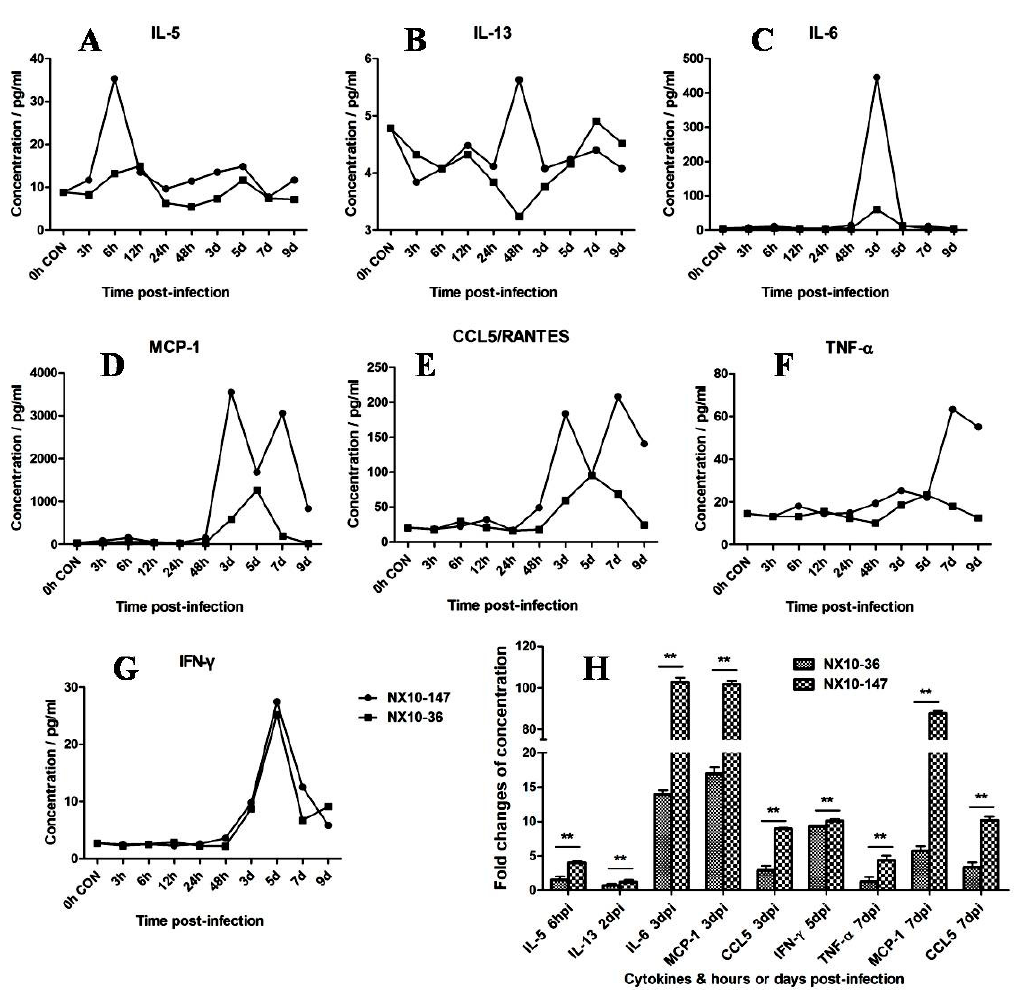
Figure 9. Dynamic detection of inflammatory cytokines and chemokines in the sera of EV71 (NX10-147 and NX10-36)-infected mice sacrificed at 3, 6, and 12 hpi and 1, 2, 3, 5, 7, and 9 dpi. The mean serum concentrations of cytokines and chemokines ( A ) interleukin (IL)-5, ( B ) IL-13, ( C ) IL-6, ( D ) monocyte chemotactic protein 1 (MCP-1), ( E ) chemokine (C-C motif) ligand 5 (also called Regulated upon Activation, Normal T-cell Expressed, and Secreted) (CCL5/RANTES), ( F ) tumor necrosis factor (TNF)- α , and ( G ) interferon (IFN)- γ are shown. The fold changes in IL-5(6 hpi), IL-13(2 dpi), IL-6(3 dpi), MCP-1(3 and 7 dpi), CCL5/RANTES (3 and 7 dpi), IFN- γ (5 dpi), and TNF- α (7 dpi) in the mouse models of severe and mild infection are shown ( H ) ( ** p < 0.01).